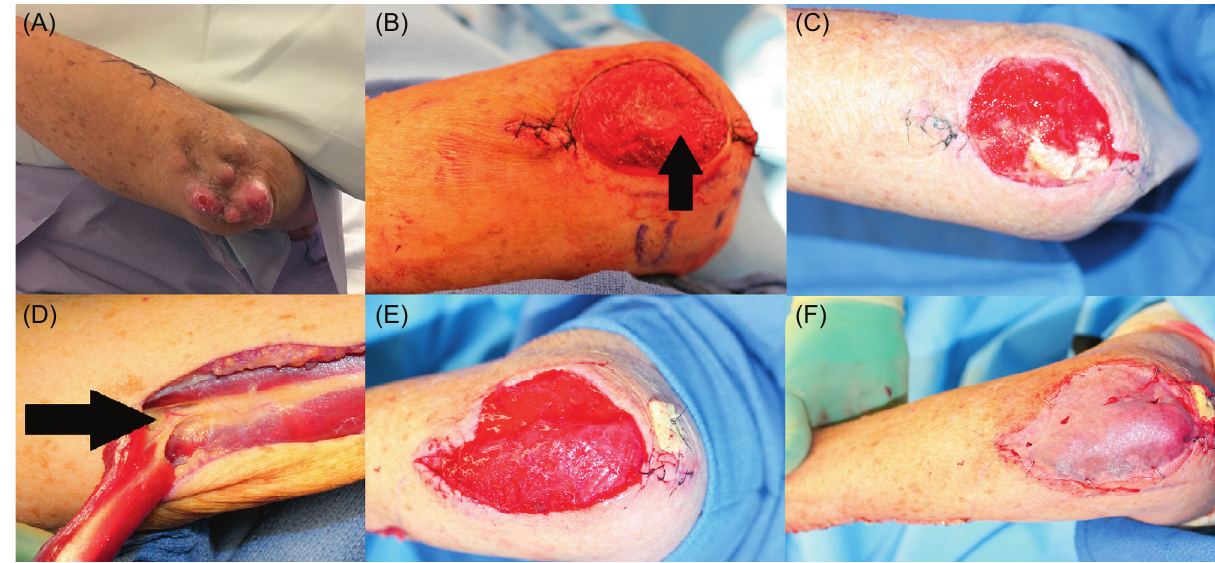
Figure 5. Seventy-one-year-old male with a myxoid sarcoma of the left elbow area. (A) Painless mass developing over the course of a few years with local progression and the development of satellite lesions. (B) Resection of the tumor including the periosteum (arrow) of the ulnar bone. As the examination of the margins was pending, this wound was temporarily protected by the subsequent application of a VAC-system. (C) One week after primary resection: the defect remains non-infected and prepared for reconstructive surgery. A muscle flap was necessary for sufficient coverage of the exposed bone and to provide well-vascularized coverage in case of adjuvant radiotherapy as part of the treatment protocol or in case of a recurrence. A skin graft would not have offered adequate durability attributes and would have been unlikely to heal over the periosteum-denuded bone. (D) Dissection of the flexor carpi ulnaris muscle flap: major vascular pedicle entering the deep surface of the muscle 6 cm distal to the elbow (arrow) with the visible delicate anastomoses forming the cubital vascular rete. (E) Defect coverage with the muscle flap. The distal tendon was embedded underneath the proximal wound edge and fixed percutaneously to a gauze bolster to ensure healing without flap dislodgment. (F) Split thickness skin graft covering the muscle flap